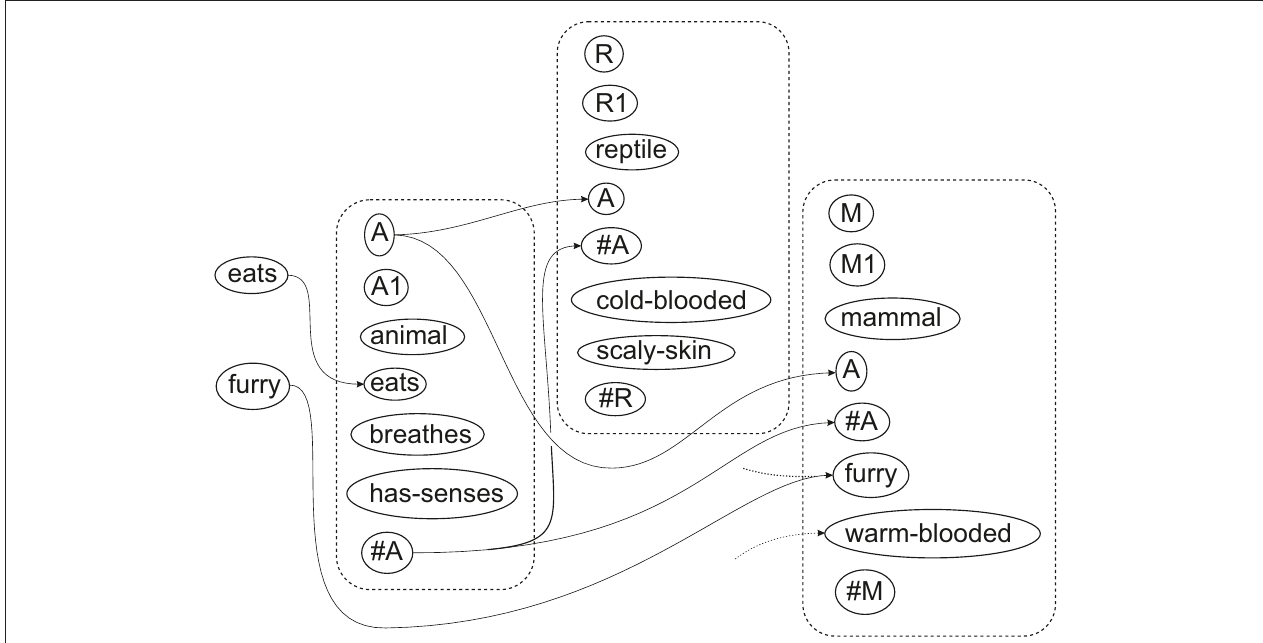
FIGURE 7 | How part of the multiple alignment shown in Figure 6 may be realized in SP-neural—showing two of the attributes from column 0 in the multiple alignment and with “animal” and “mammal” pattern assemblies corresponding to patterns from columns 4 and 3—with an associated pattern assembly for “reptile.” The conventions are the same as in Figure 3